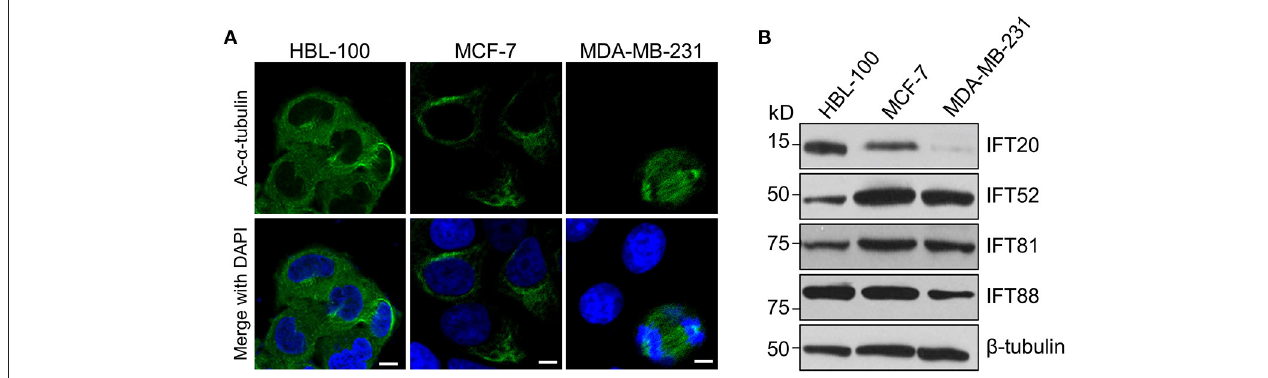
FIGURE 1 | The expression level of IFT20 negatively correlates with the malignancy of breast cancer cells. (A) Representative immunostaining of Ac- α -tubulin (green) in HBL-100, MCF-7, and MDA-MB-231 cells from two independent experiments showed that no cilia were formed in these three cell lines when treated with serum starvation for 36h; Ac- α -tubulin represents acetylated- α -tubulin as the primary cilia marker (green); the nucleus is stained by DAPI (blue). Scale bar, 10 µ m. (B) Western blots of cell lysates from HBL-100, MCF-7, and MDA-MB-231 cells probed with antibodies raised against IFT20, IFT52, IFT81, and IFT88. β -tubulin was used as the loading